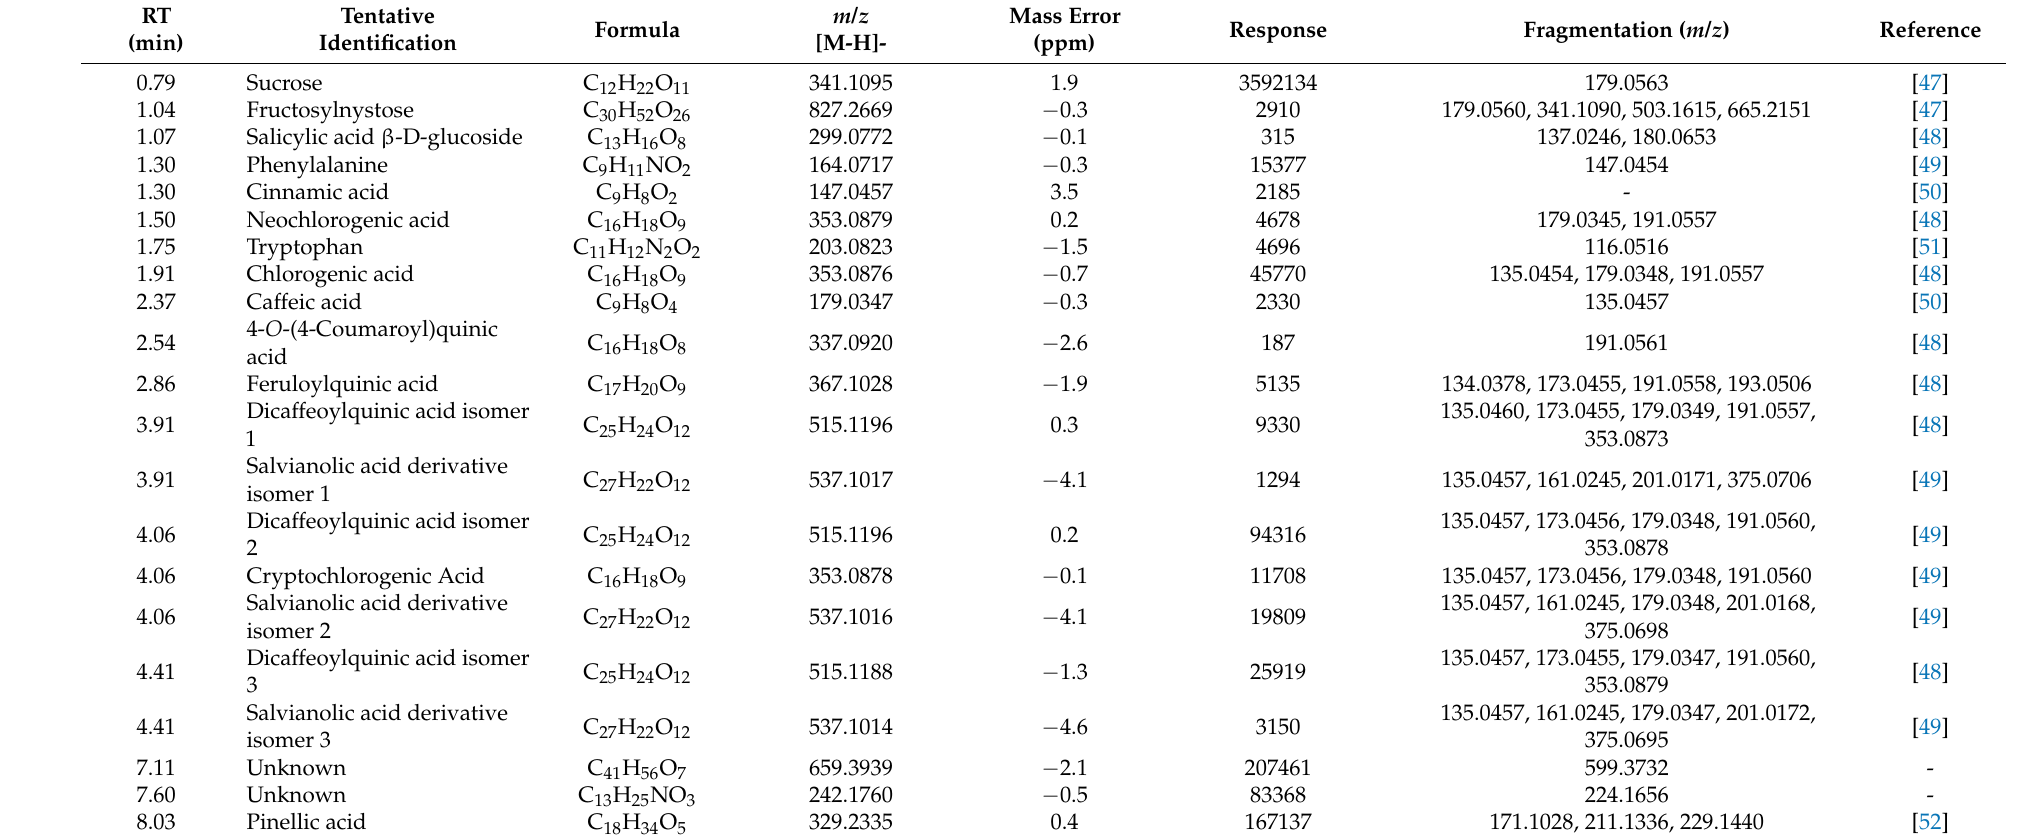
Table 2. UPLC-QTOF-based mass spectra showing the fragmentation patterns of H. tuberosus